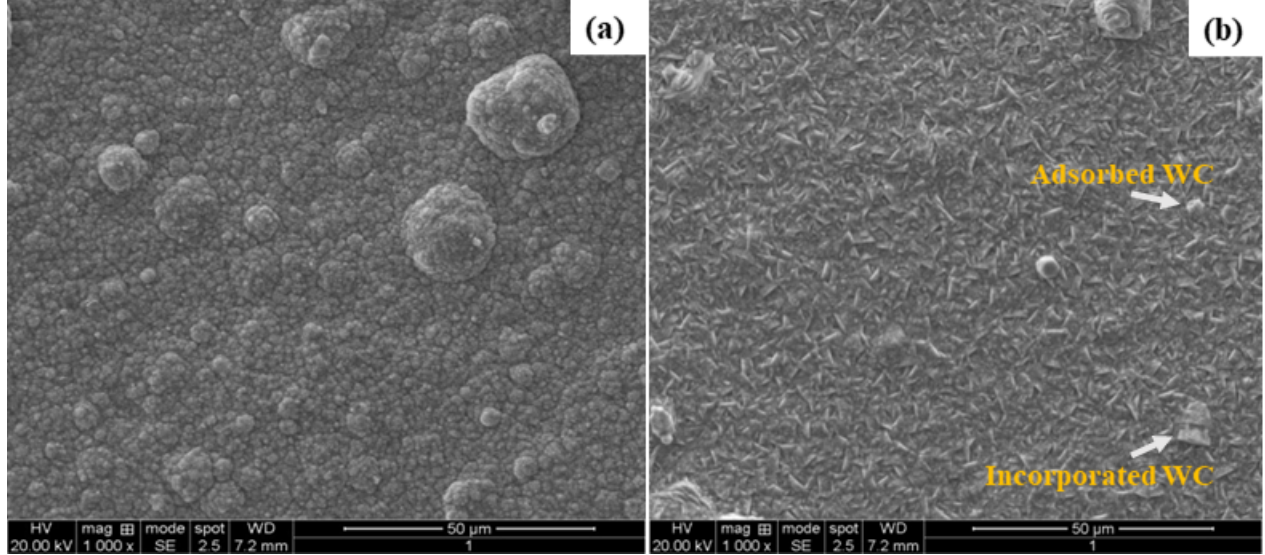
10 of 18 Figure 6. Texture coefficient (Tc) of Zn–Ni alloy and Zn–Ni–WC composites nanocoating. The surface morphologies of Zn–Ni alloy and Zn–Ni–WC composites coatings are subjected to SEM are shown in Figure 7. Figure 7a shows the presence of excessive ac- cumulation of Zn–Ni platelets at random in the Zn–Ni alloy coatings. However, in the Zn–Ni–WC composites, the Zn–Ni platelets are well stacked on the steel substrate. In addition, the deposition of the Zn–Ni coating was uneven and coarse, whereas the depo- sition of the Zn–Ni–WC composite nanocoating had a smooth and fine-grained structure